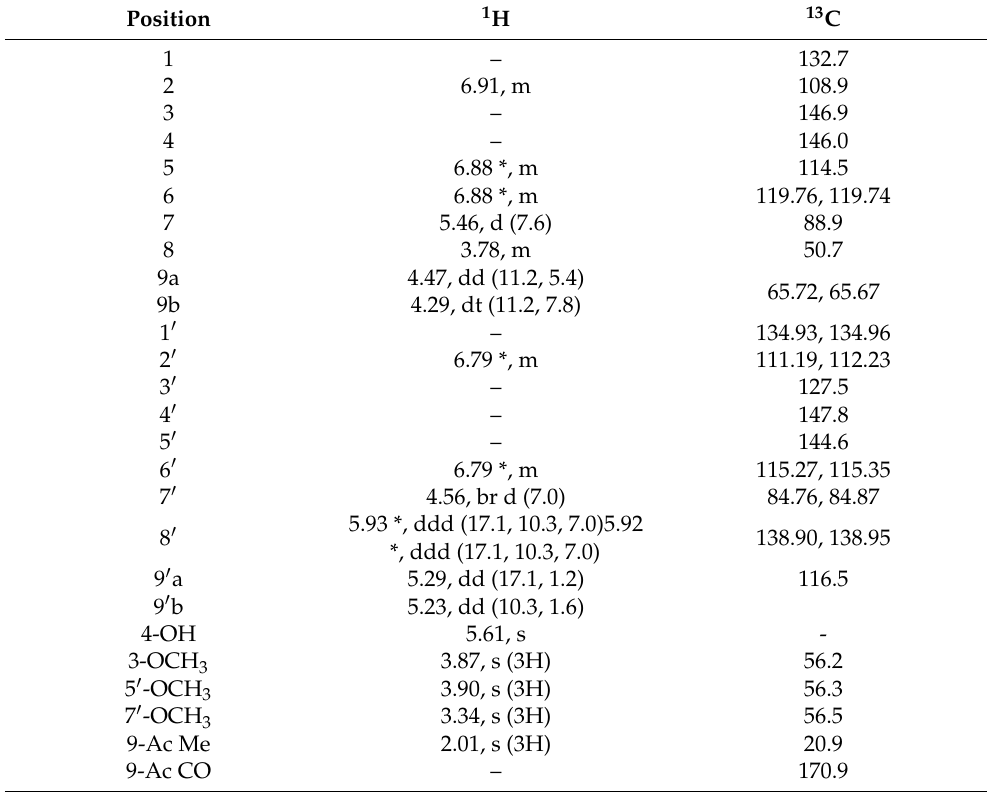
Table 2. 1 H (500 MHz) and 13 C NMR (125 MHz) data of compound 4 in CDCl 3 ( δ H in ppm, J in